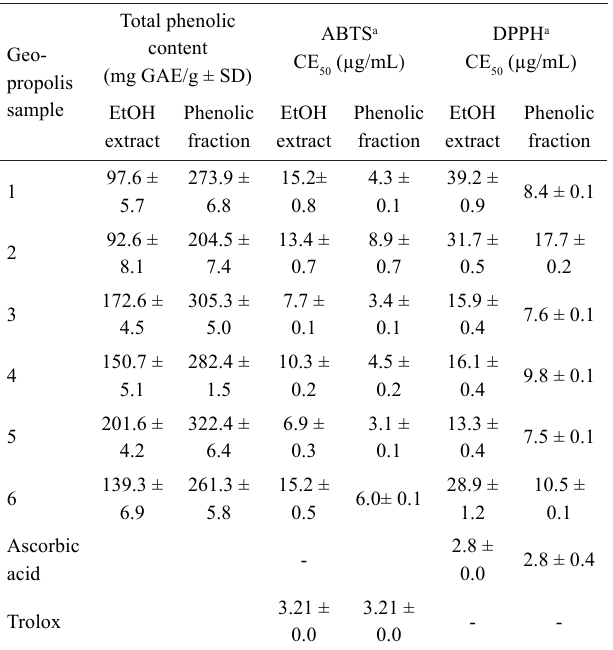
Table 2 . Total phenolic and free radical-scavenging activity of M. subnitida geopropolis samples.